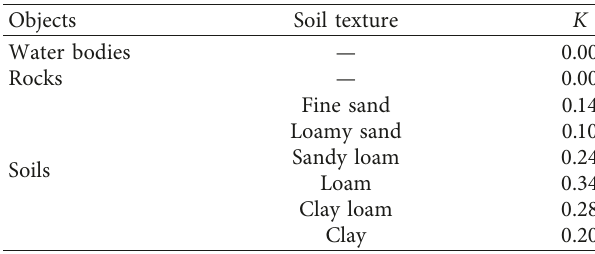
Table 1: The K factor based on soil texture and organic matter content (after Stewart et al. 1975 cited in